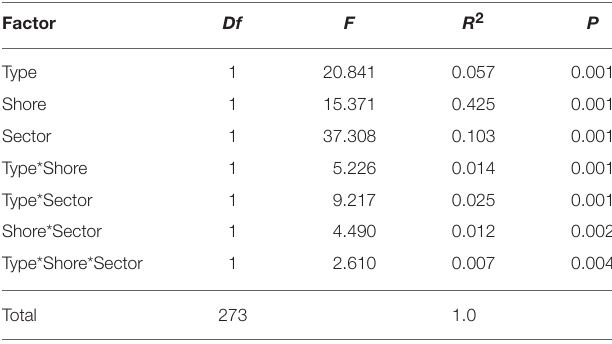
TABLE 1 | Summary of Permutational Multivariate Analysis of Variance tests to compare Symbiodinium community composition among juveniles and sediments.